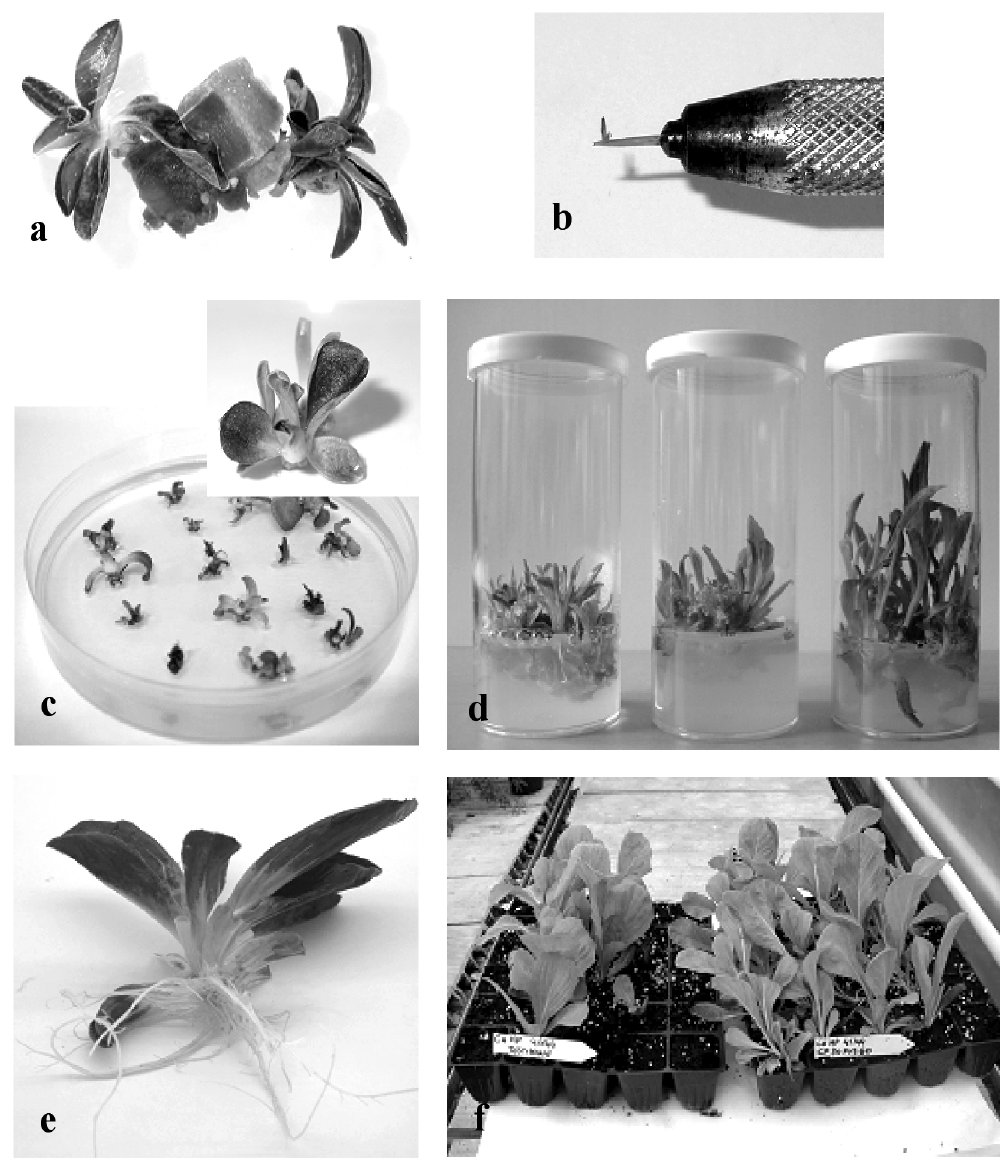
Fig. 1 - Cryopreservation of red chicory “Rosso di Chioggia” line (a-f). a - microshoots induced adventitiously from a leaf portion; b - a shoot tip just after excision from a shoot bud; c - shoot tip survival after three weeks and a well-formed shoot tip after cryopreservation with 60 min of PVS2 treatment (detail); d - regrowth in plastic cylinder on MS medium with 0.5 µ M BA; e - cryopreserved rooted microshoot; f - plantlets from cryopreservation, after potting and acclimation in the